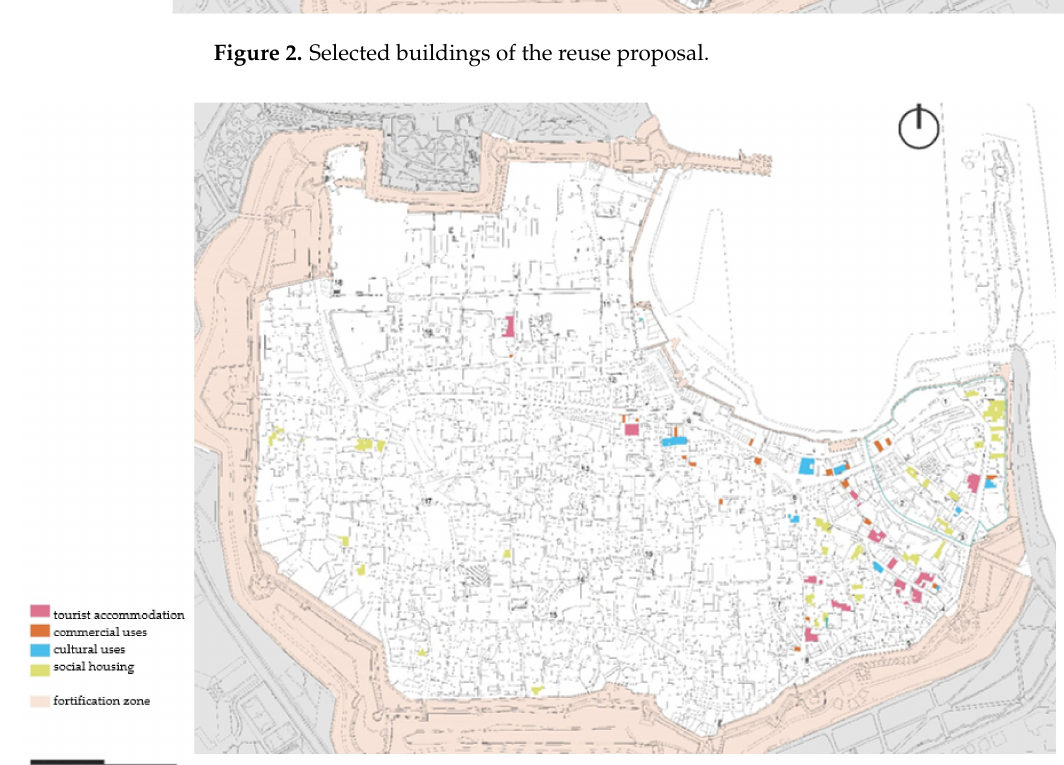
Figure 3. Proposed land uses of the selected